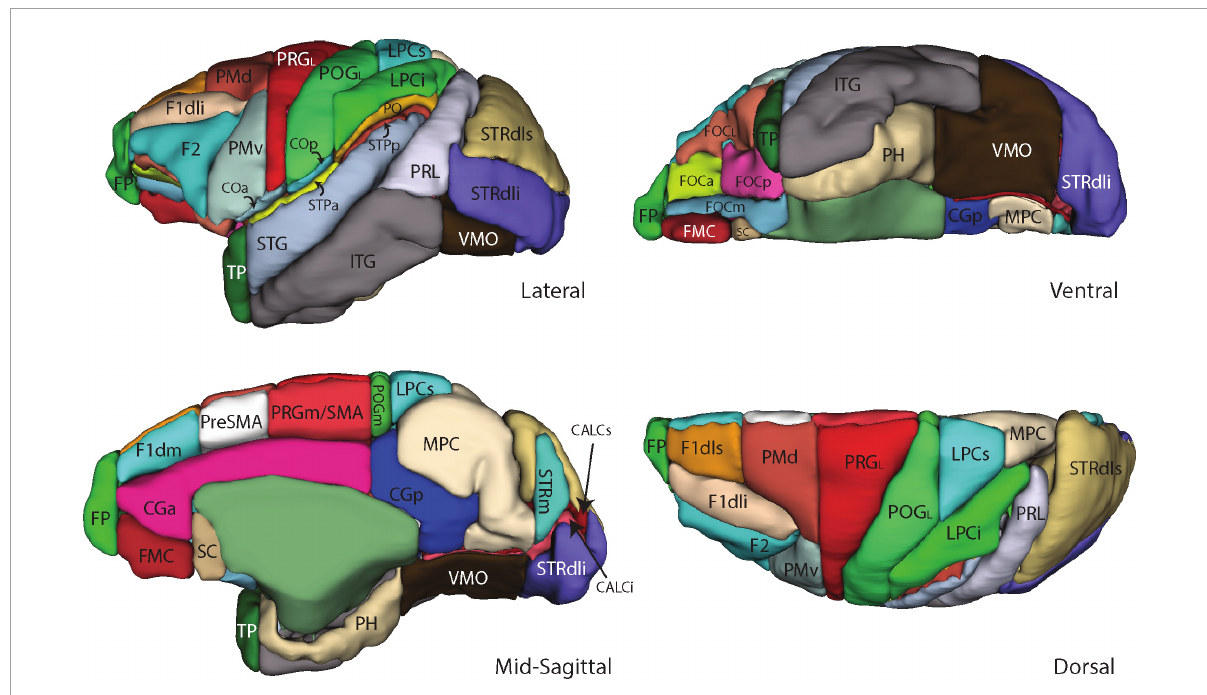
FIGURE4 Three-dimensional representation of the revised Harvard-Oxford Atlas parcellation of the macaque monkey brain, mHOA2.0. Abbreviations are listed in Table 6